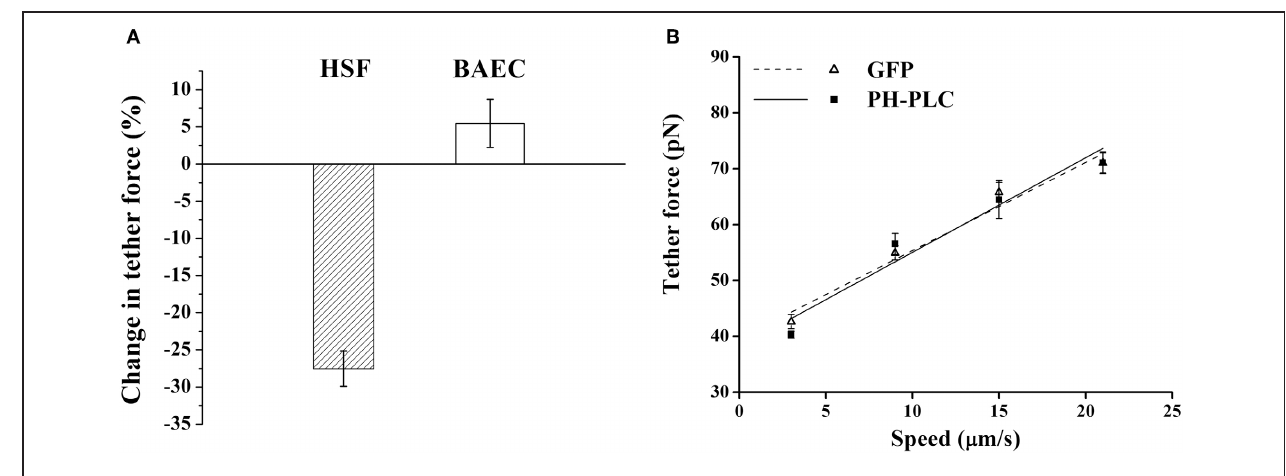
FIGURE 2 | Effect of PIP2 on the tether force. (A) Change in the magnitude of tether force upon PH-PLC-GFP transfection at 15 μ m/s tether extraction speed. In HSF the negative value of the change corresponds to a drop in tether force, whereas in BAEC the change is within the experimental error. (B) Tether force versus pulling speed in